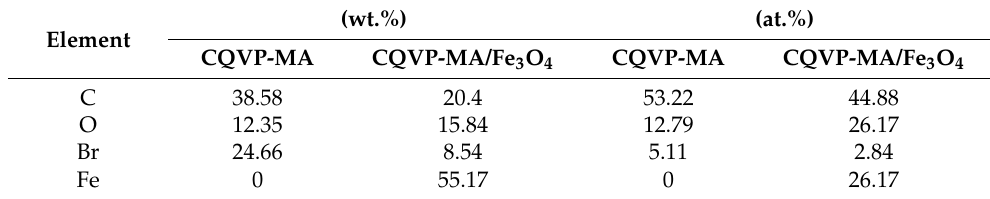
Table 1. EDX quantification of elements normalized for CQVP/MA and CQVP/MA-Fe 3 O 4 .